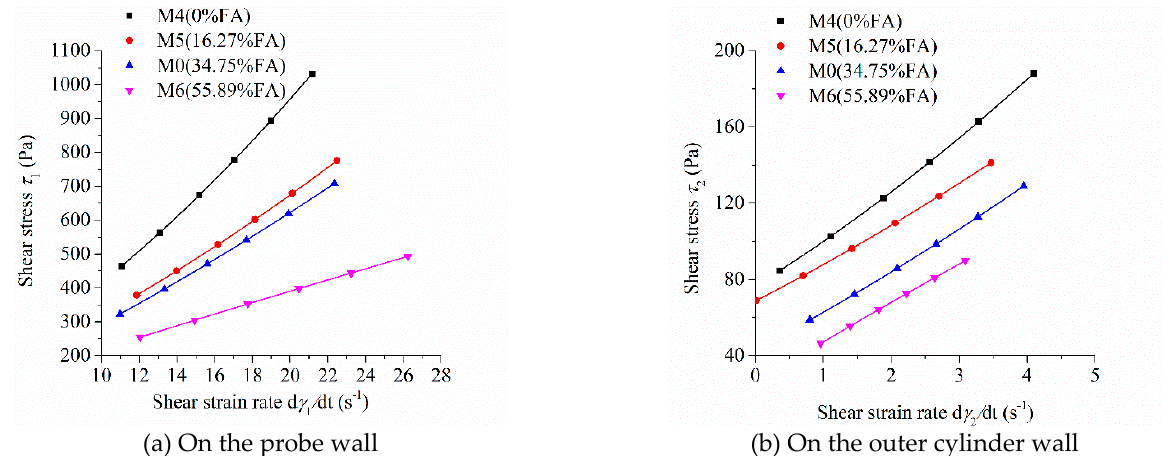
Figure 6. Relationship between shear stress and shear strain rate of mortars with different fly ash (FA) contents.